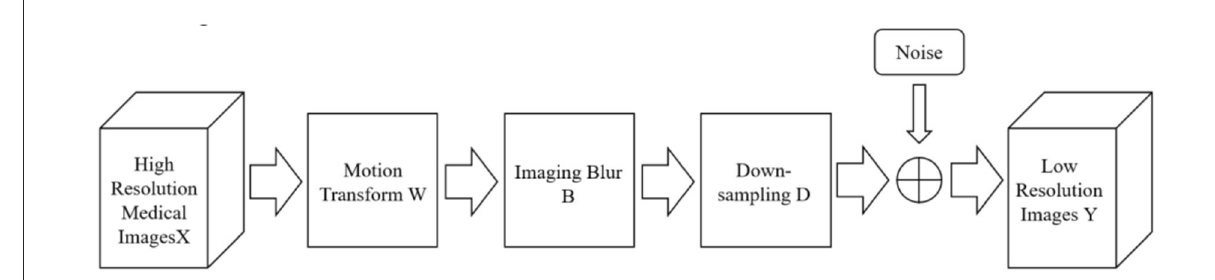
FIGURE1 Reconstruction-based super-resolution reconstruction step diagram.